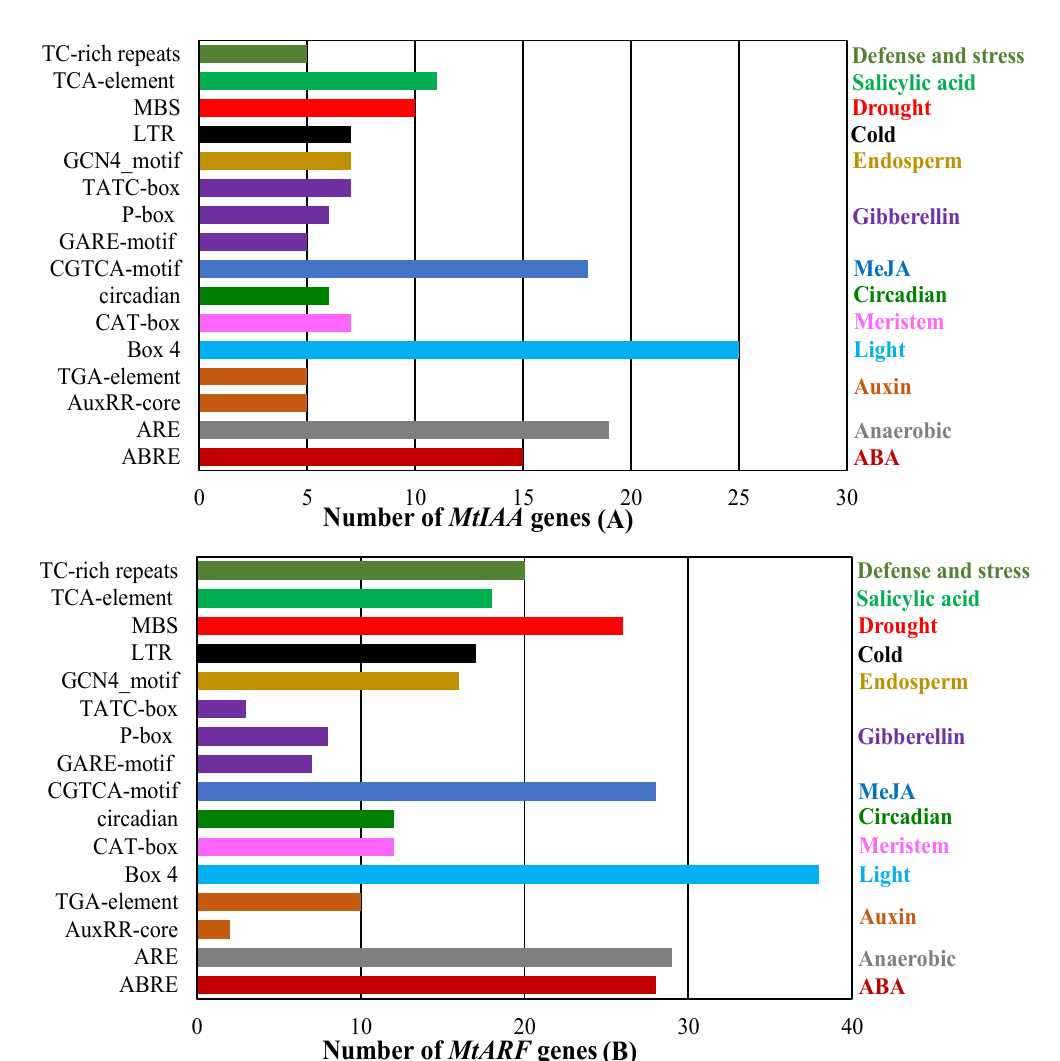
Figure 5. Number of MtIAA ( A ) and MtARF ( B ) genes containing various cis -acting elements. ABRE, ABA-responsive element; ARE, anaerobic induction element; AuxRR-core and TGA-element, cis -acting element involved in auxin-responsive element; CAT-box, cis -acting element involved in meristem expression element; circadian, cis -acting element involved in biologic rhythms; CGTCA-motif, cis -acting element involved in MeJA response; GARE-motif, P-box and TATC-box, cis -acting element involved in GA response; GCN4-motif, cis -acting element involved endosperm expression; LTR, cis -acting element involved in low-temperature response; MBS, cis -acting element involved in drought-inducibility; TCA-element, cis -acting element involved in SA response; TC-rich repeats, cis -acting element involved in defense and stress.